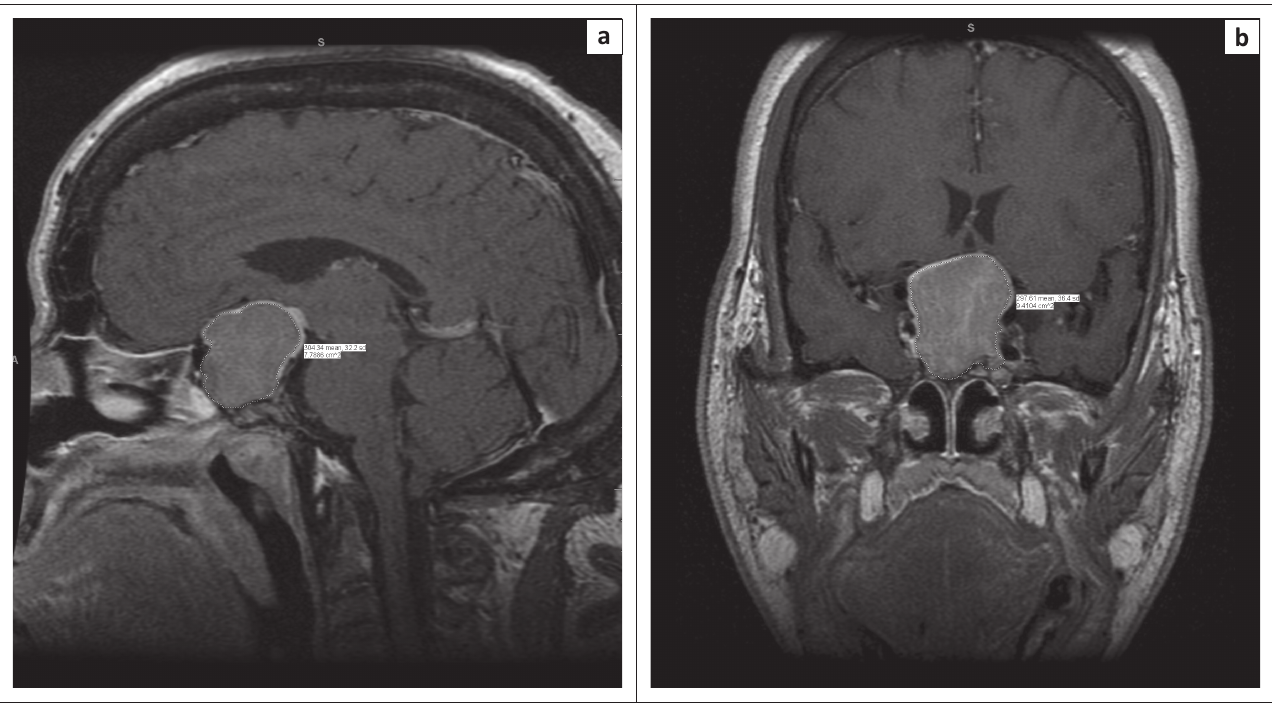
Note : Outline is lobulated with suprasellar extension and the characteristic ‘snowman’ appearance. The images demonstrate the area tracings. Source : PACS image from 3 megapixel BARCO reporting monitor at the Universitas Academic Hospital FIGURE 2: Large non-functioning pituitary macroadenoma in a 54-year-old male: Sagittal (a) and coronal (b) T1-weighted images (post-contrast) of the